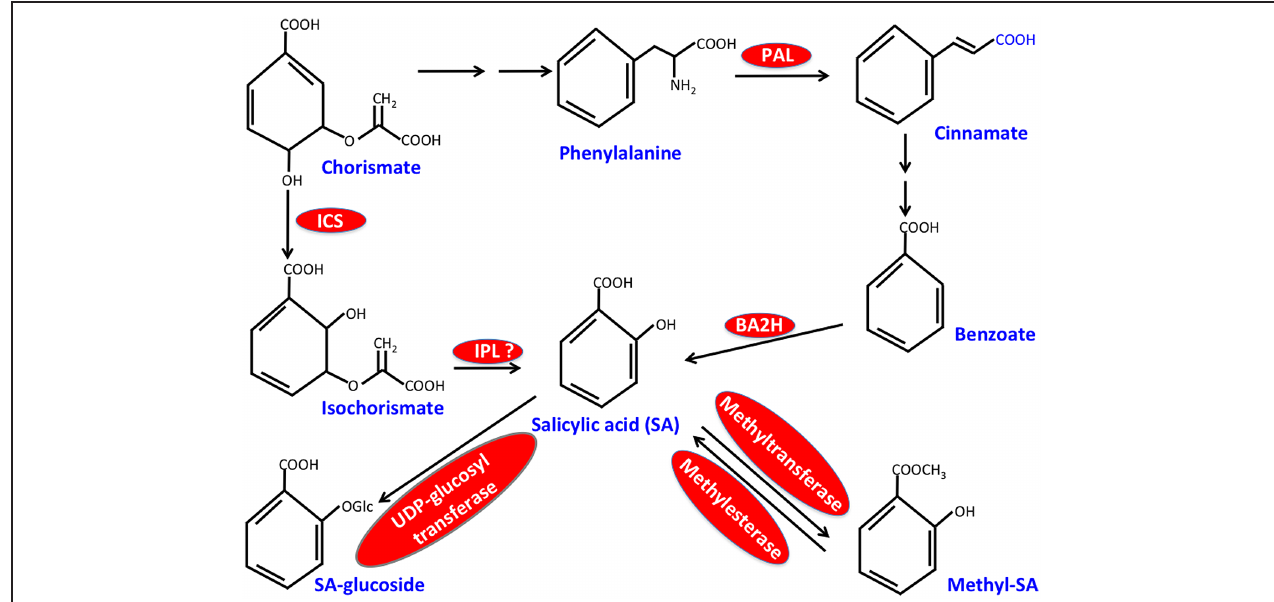
FIGURE 1 | Simplified scheme for salicylic acid (SA) biosynthesis in plants. Critical enzymes are shown in red. ICS, isochorismate synthase; IPL, isochorismate pyruvate lyase; PAL, phenylalanine ammonia-lyase; BA2H, benzoic acid 2-hydroxylase.